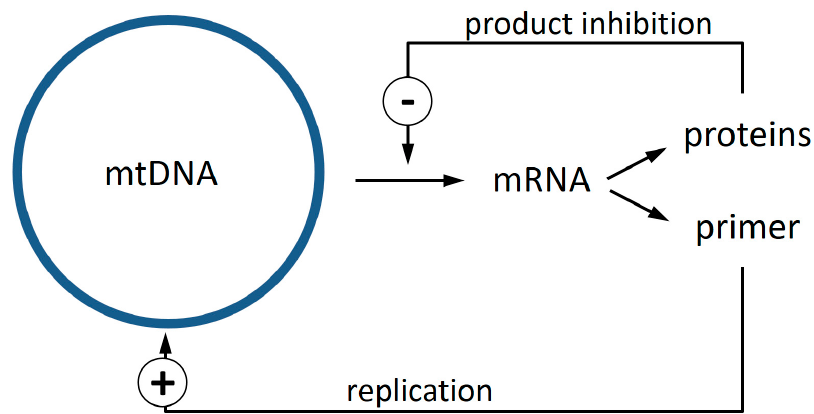
Figure 1. The replication of mitochondrial DNA (mtDNA) in vertebrates is primed via processed mRNA molecules [22,23]. We propose that a product inhibition exists that diminishes transcription ( − ), and thus replication, if sufficient proteins are available. If a deletion event eliminates the genes for proteins that participate in this feedback, transcription and also replication will not be downregulated in such mutants, resulting in a replication advantage (+).